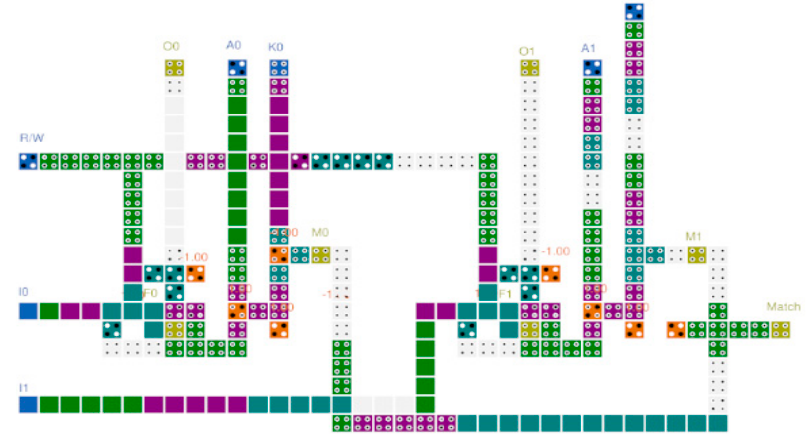
(1) Figure 11 shows each layer of the QCA CAM cell separately based on the logic dia- gram of Figure 10. The position of the cells can be identified using the index written on the row and column of each figure. The AND/OR gates used in the circuit are multi-layer structures given in Figure 4. The XNOR gate suggested in Figure 9 is used in the match unit. For signal stability, two redundant cells are inserted into Layer2 (b,10) and Layer3 (c,11). ( d ) Figure 11. Proposed QCA CAM cell: ( a ) All layer; ( b ) Layer 1; ( c ) Layer 2; ( d ) Layer 3. Figure 12 shows the circuit expanded to a 1 × 2 CAM using the proposed QCA CAM cell. In the two CAM cells, the operation of the memory unit is controlled according to the